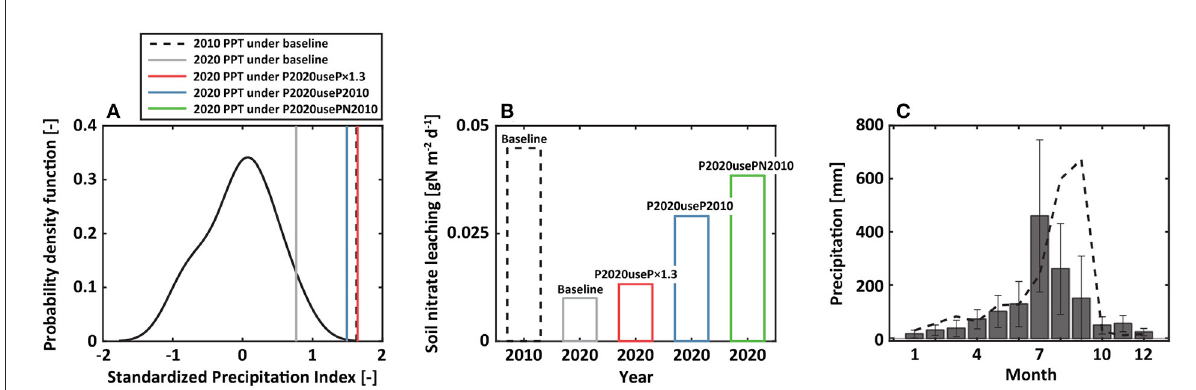
FIGURE7 Analysis of precipitation to explore excessive the 2010 N event. (A) The probability density function of yearly standardized precipitation index. (B) Soil nitrate leaching under baseline, a scenario of 2020 precipitation multiplied by 1.3 (P2020useP × 1.3, red), a scenario of replacing 2020 precipitation with 2010 precipitation (P2020useP2010, blue), and a scenario of P2020useP2010 with substituting soil carbon and nitrate concentrations on Jan 1, 2010, for those on Jan 1, 2020 (P2020usePN2010, green). Dynamics associated with 2010 and 2020 were in dotted black and gray lines. (C) Monthly precipitation in 2010 was overlaid on monthly mean precipitation with associated standard deviations (error bars).